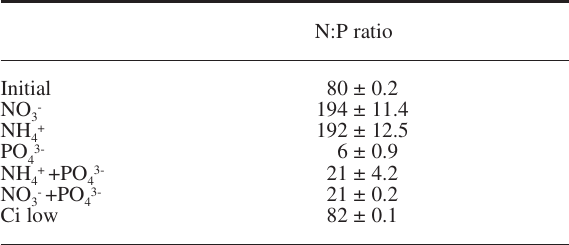
Table 1.- Atomic N:P ratios in C. linum tissues at the beginning and end of the incubation period. Mean ± standard errors of four replicates are